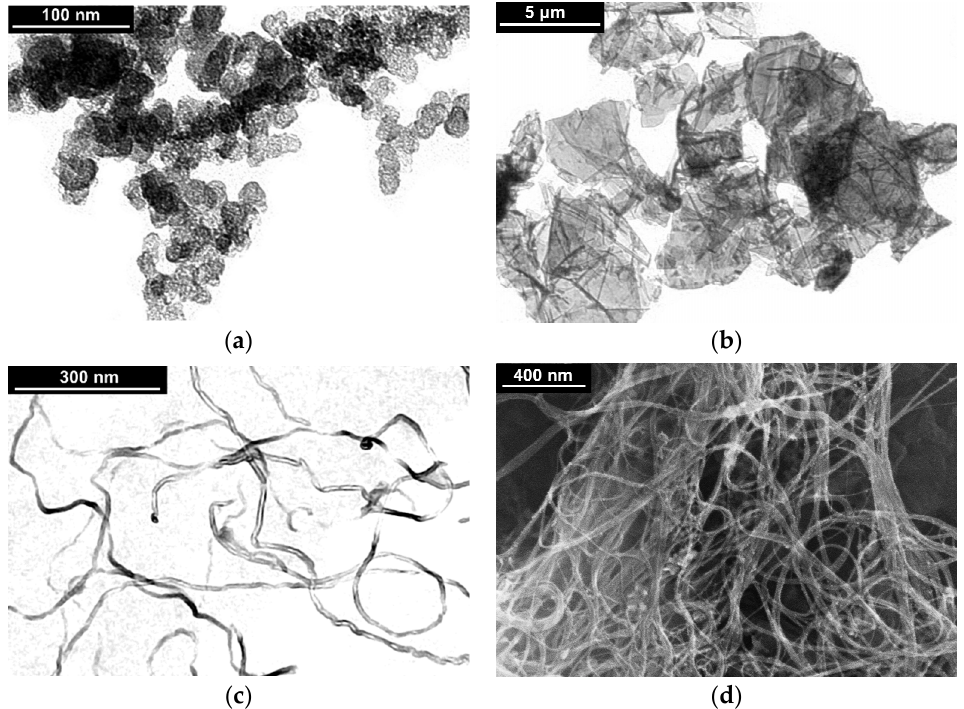
Figure 1. Results of transmission ( a – c ) and scanning ( d ) electron microscopy for the powders of various carbon nanoparticles used as the fillers (( a )—carbon black (CB); ( b )—graphene nanoplatelets (GnPs)s; ( c )—multiwalled carbon nanotubes (MWCNTs); ( d )—single-walled carbon nanotubes (SWCNTs)).